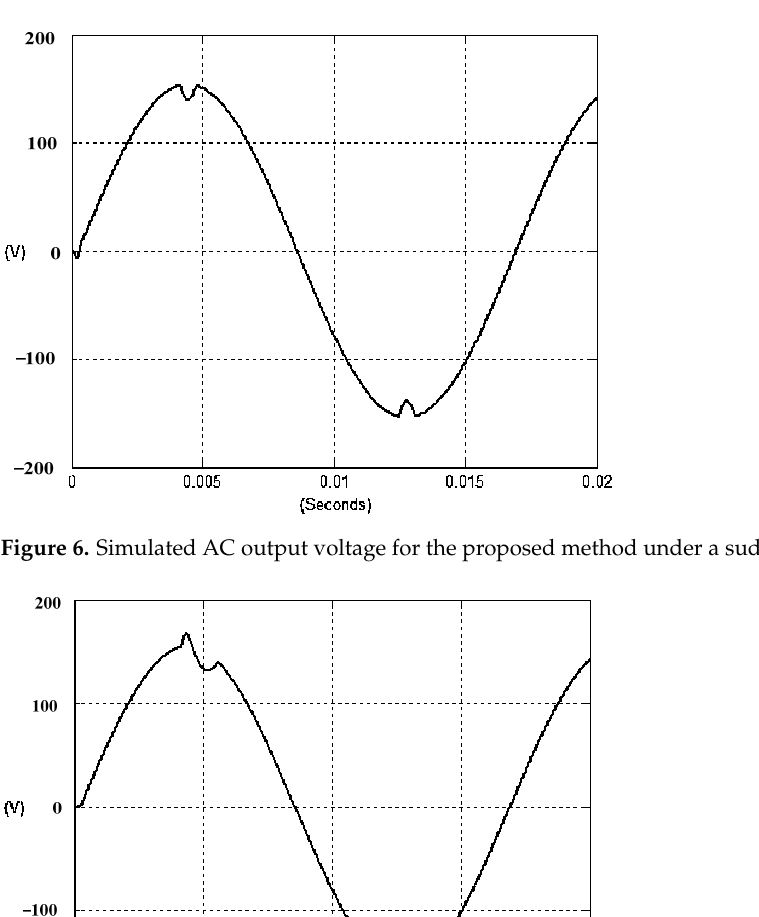
Figure 5. Simulated AC output voltage for the traditional SMRL under a sudden increment of load.